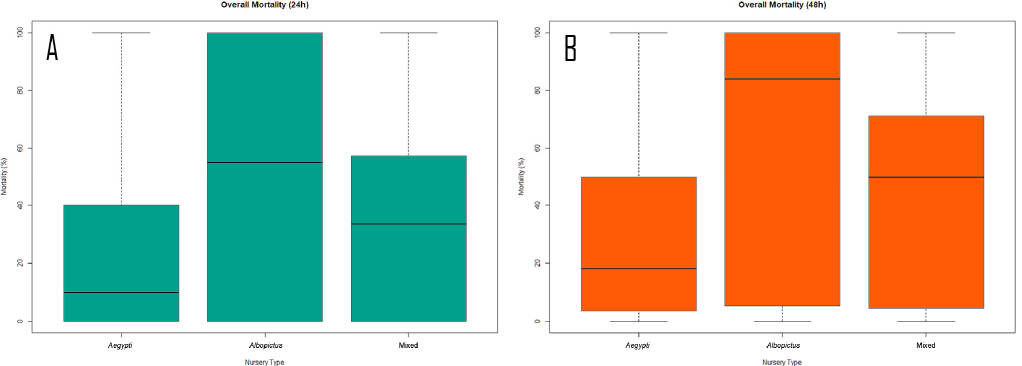
Figure 4. ( A ) Overall mortality among all the nursery types tested over all the inoculum concentrations used after ( A ) 24 h past initial exposure. ( B ) 48 h past initial